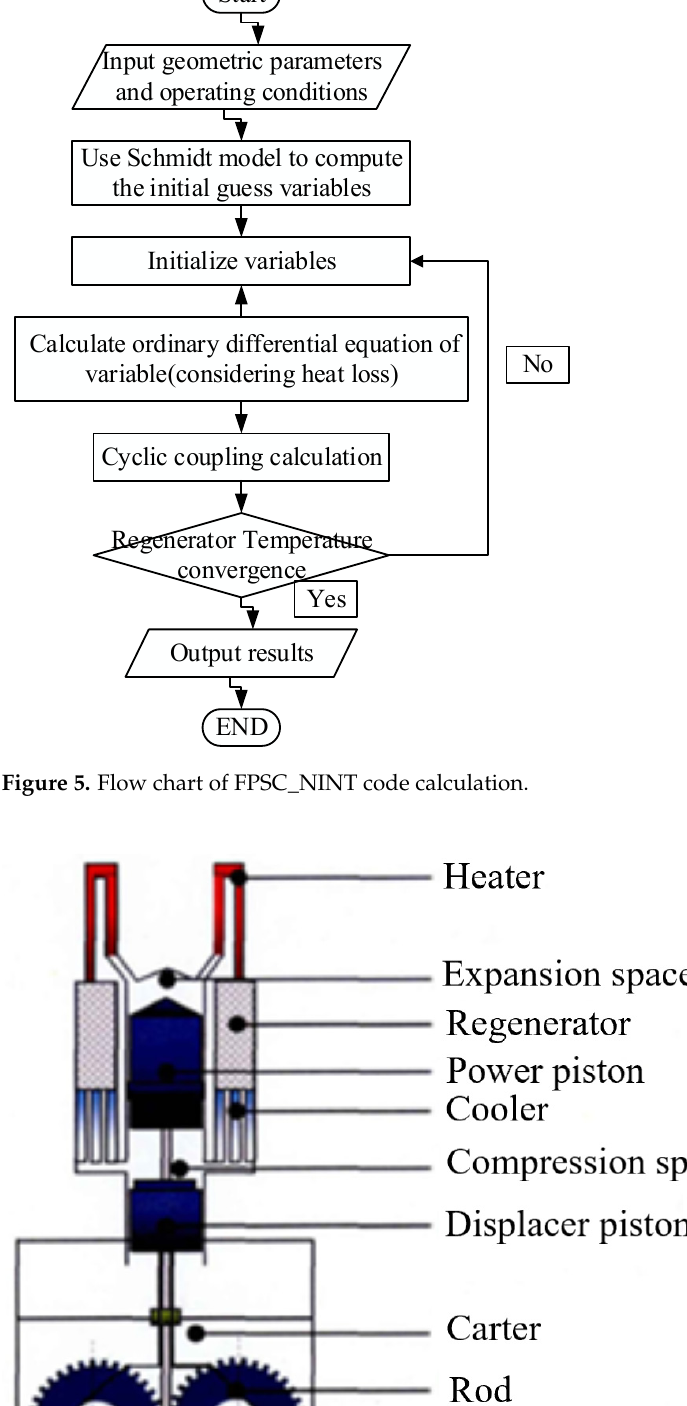
Table 1. GPU-3 engine design parameters.